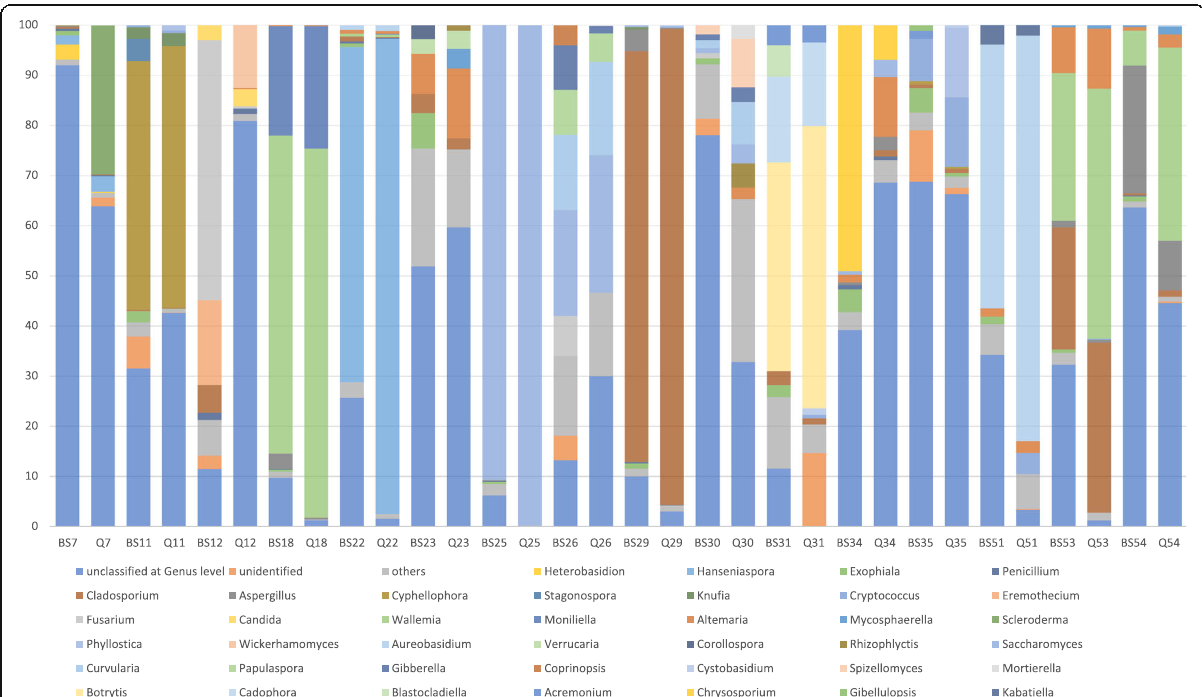
Fig. 1 Classification results at the genus levels for all 16 samples, performed through BSSH (BS) or QIIME (Q). The y -axis represents the percentage of total